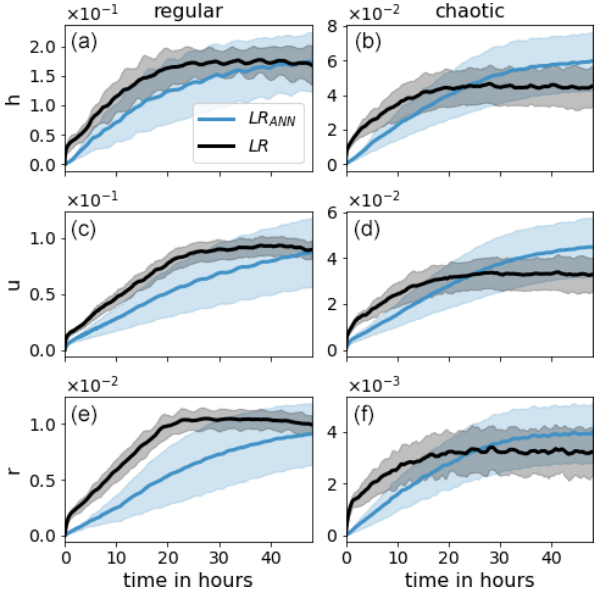
Figure 6. Same as Fig. 5 but for the